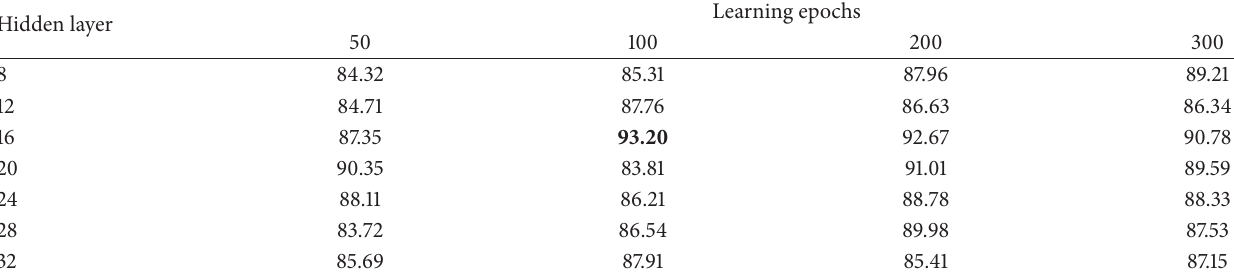
Table 7: Prediction performance of ANN in 𝛼 -FCM + ANN + Cox hierarchical models.